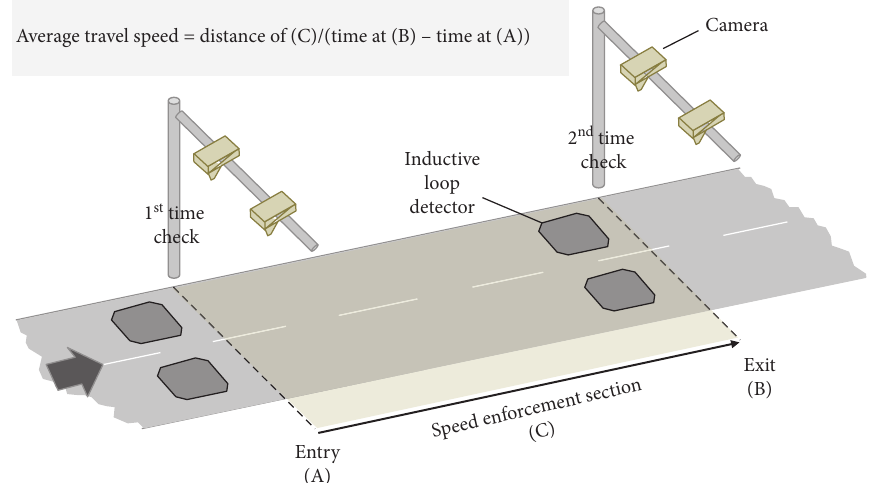
Figure 1: Illustration of section speed enforcement